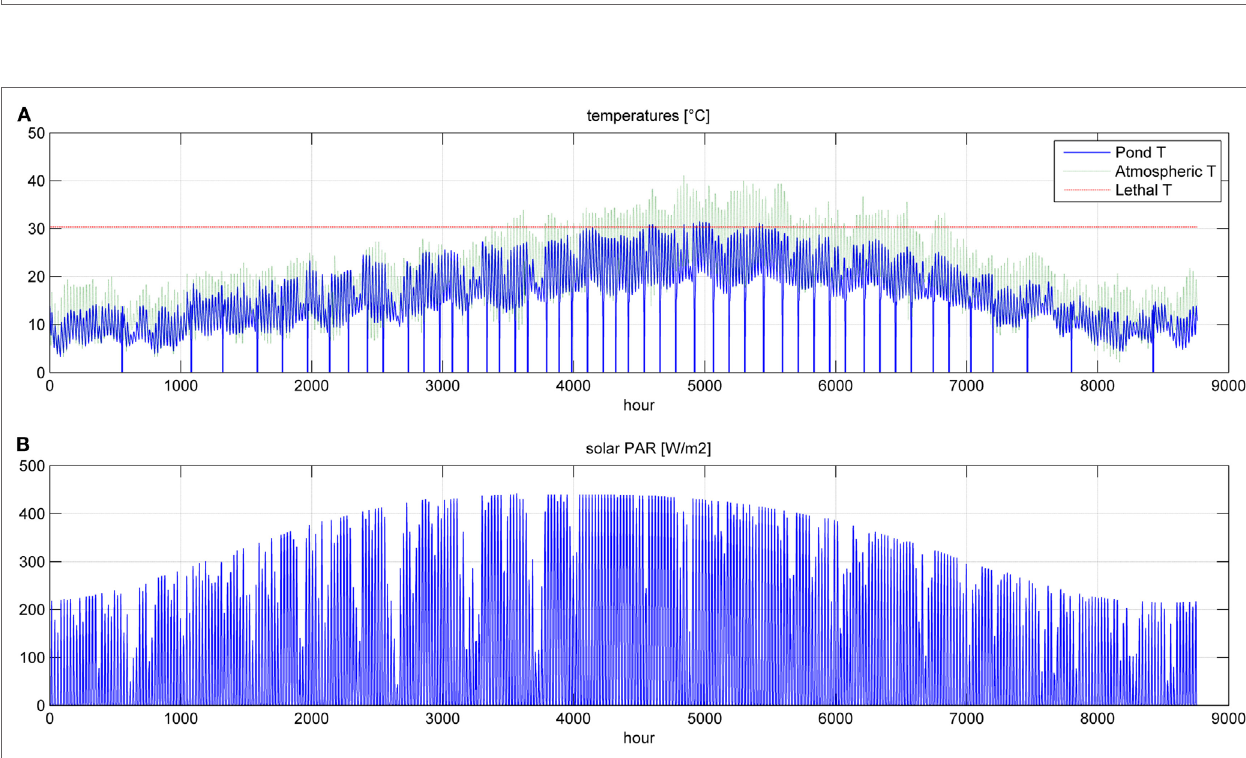
September 2015 | Volume 3 | Article 41 13 Frontiers in Energy Research | www.frontiersin.org